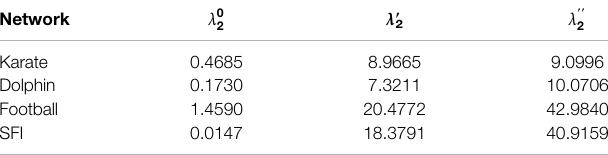
TABLE 3 | Robustness of the real-world networks and their optimized networks with respect to the two selected extreme solutions from the Pareto fronts. Network Karate